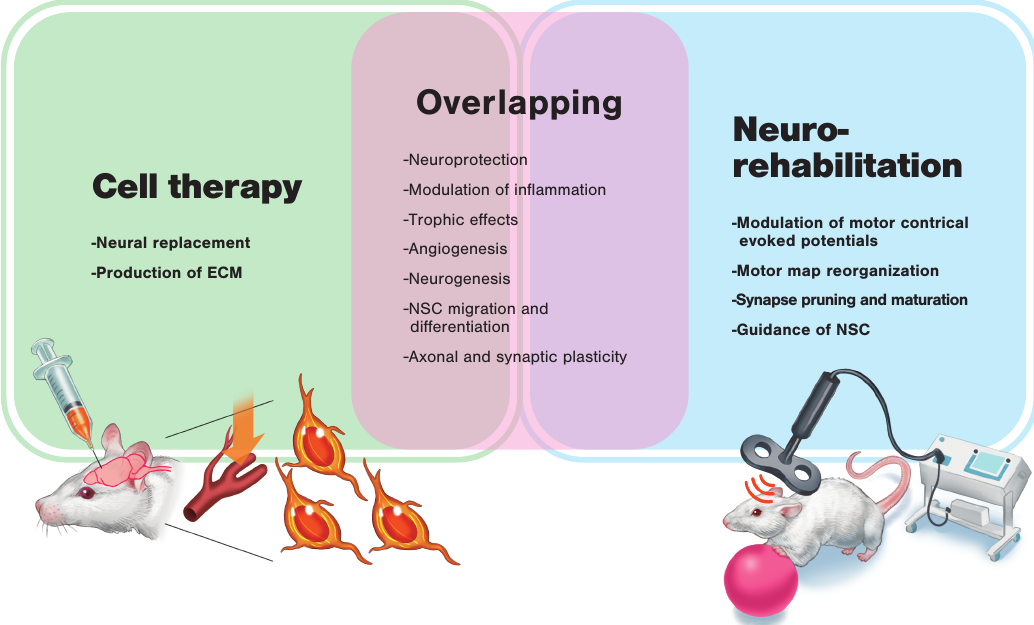
Figure 4. Possible mechanisms of action of cell therapy and neurorehabilitation for stroke recovery. Many possible mechanisms of action overlap between cell therapy and neurorehabilitation. In order to induce synergistic e ff ects, each therapy’s specific mechanism of action needs to be considered. Appropriate timing and order of the application of these therapies is also a necessary